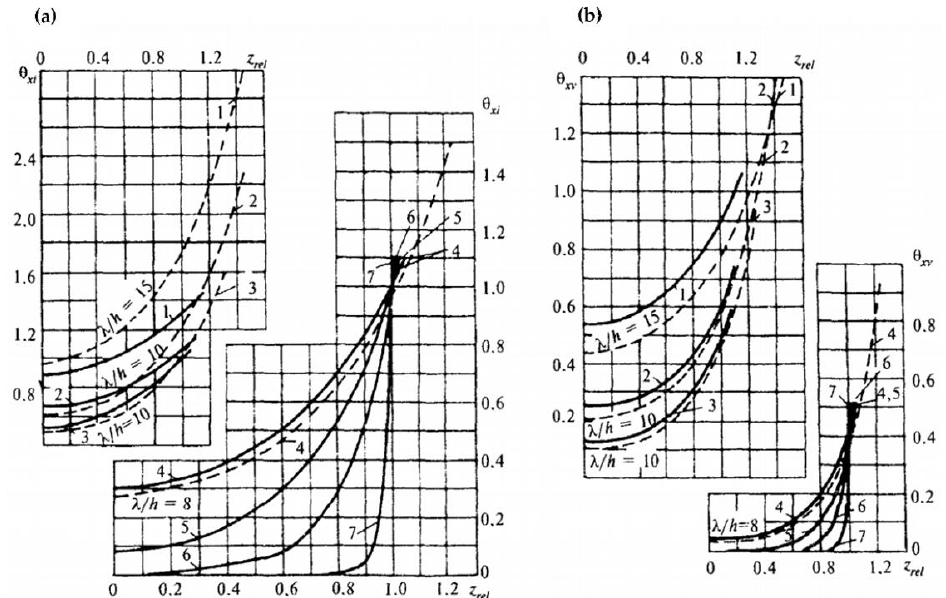
Figure 3. The graph of linear load coefficients from waves 𝜃 𝑥𝑖 ( a ) and 𝜃 𝑥𝑣 ( b ) under condition of